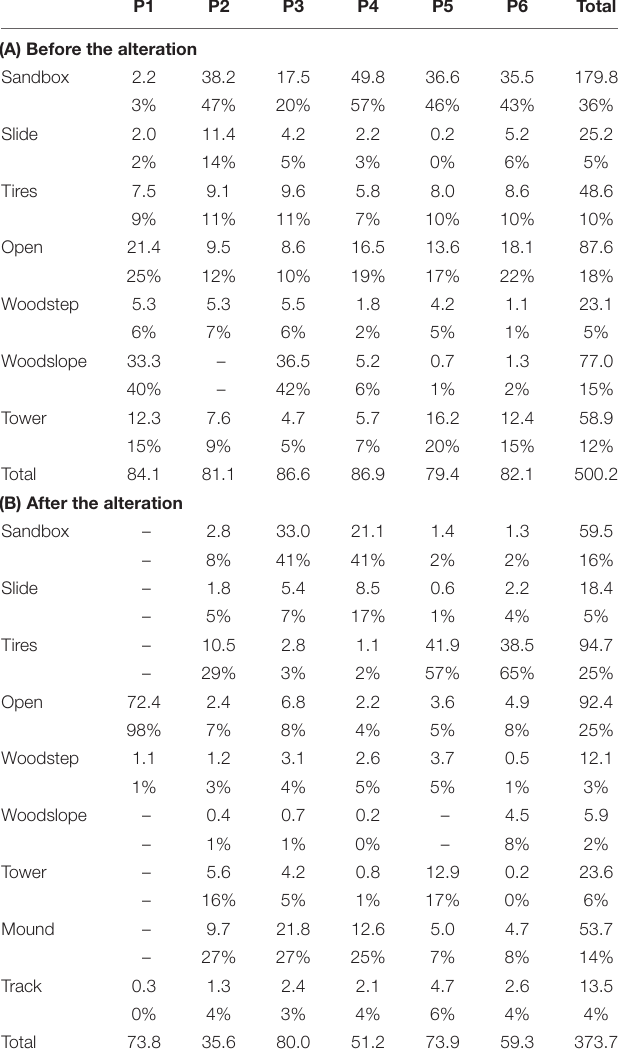
TABLE 3 | Participants’ playing time: total and in each area.